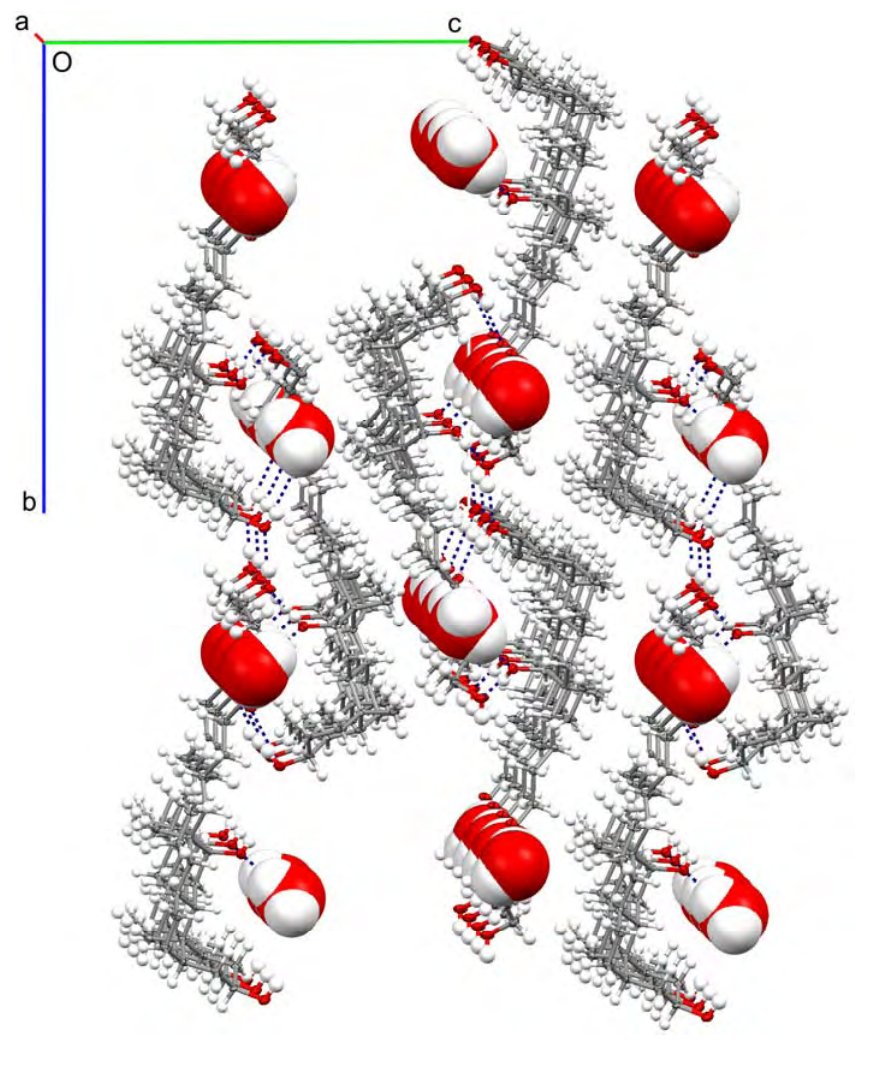
Figure 3. Packing diagram of 3 with cell axes. The size of H